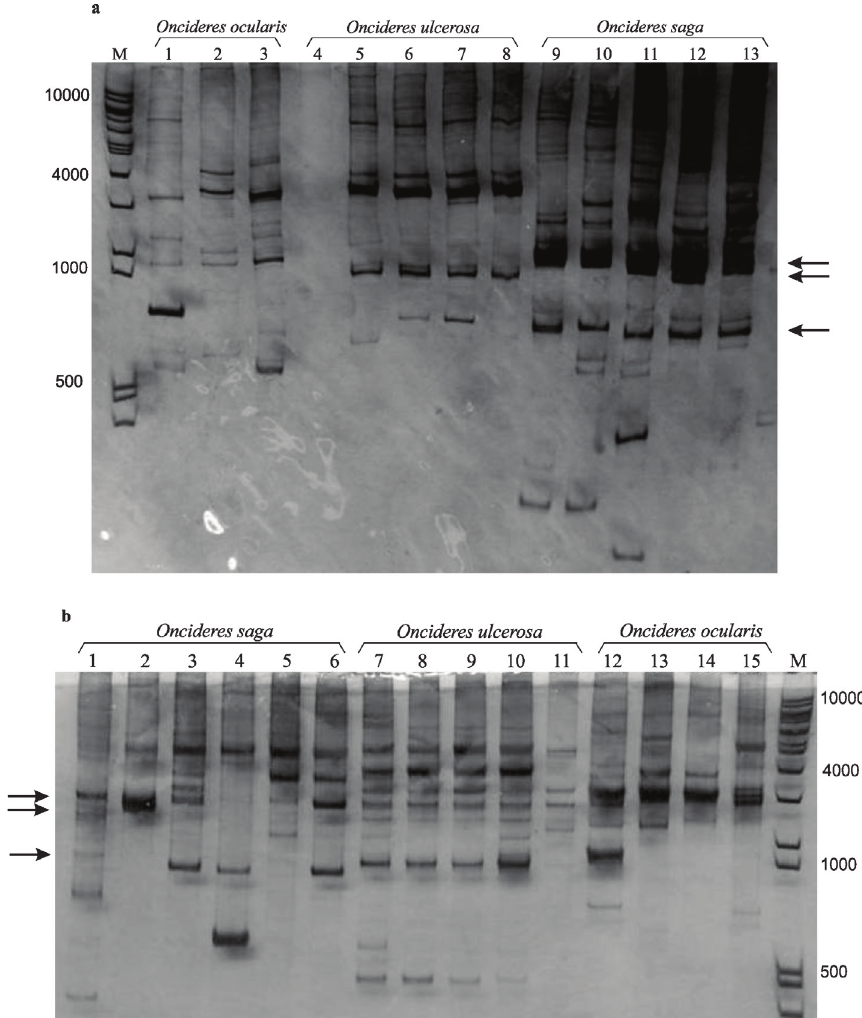
Figure 1 - Electrophoretic profiles obtained with two RAPD primers in the three species of Oncideres . ( a ) OPA-05 primer : 1 and 2 = Oncideres ocularis larvae; 3 = O. ocularis adult; 4, 5, and 6 = O. ulcerosa larvae ; 7 and 8 = O. ulcerosa adults; 9 and 10 = O. saga larvae; 11, 12, and 13 = O. saga adults. ( b ) OPB-13 primer : 1, 2, and 3 = O. saga adults; 4, 5, and 6 = O. saga larvae; 7 and 8 = O. ulcerosa adults; 9, 10, and 11 = O. ulcerosa larvae; 12 = O. ocularis adult; 13, 14, and 15 = O. ocularis larvae . M indicates the molecular marker DNA Ladder 1 Kb (Sigma). Arrows indicate specific bands of